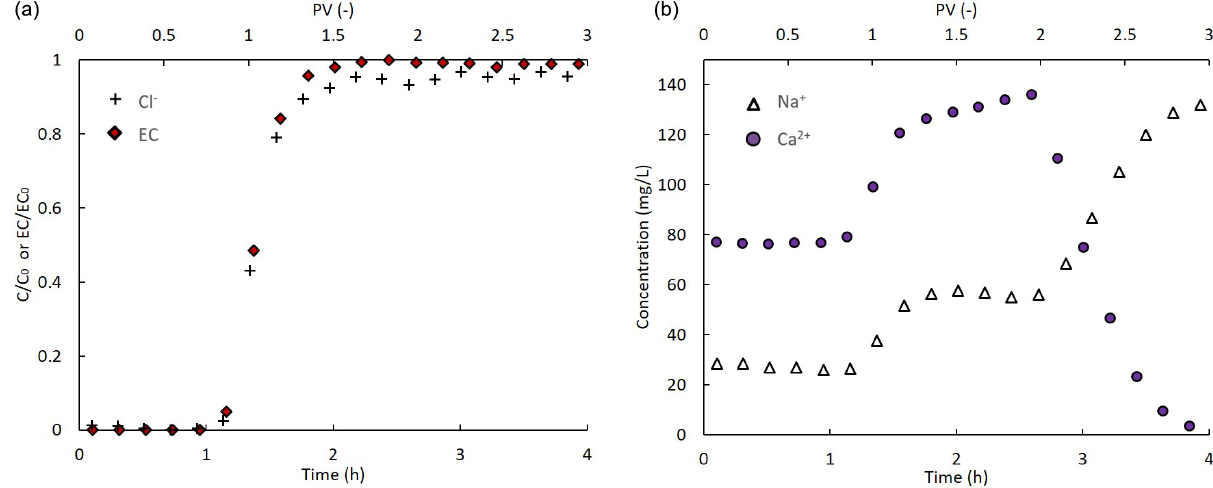
Figure 3. Outflow values vs. time (bottom horizontal axis) and pore volume (PV; upper horizontal axis) of (a) measured Cl − and EC ((+) signs and red rhombi) and (b) Na + and Ca 2 + ions (empty triangles and purple circles).